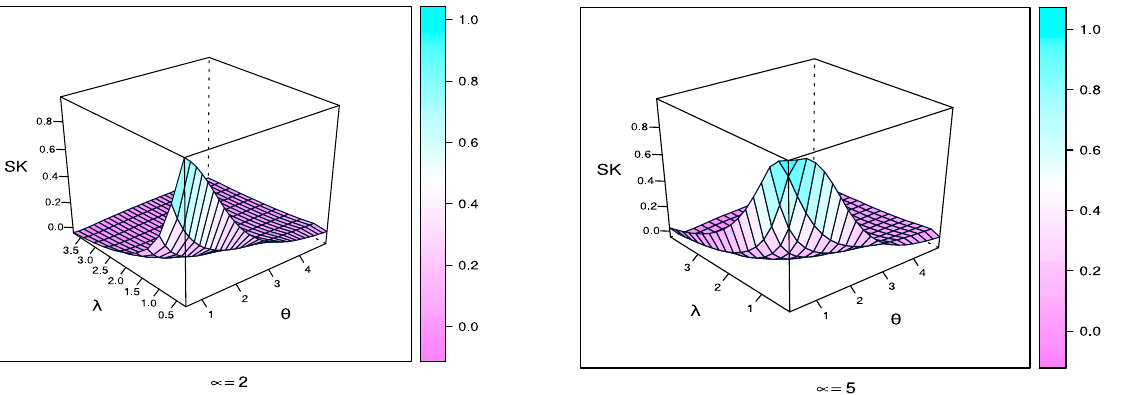
Figure 4. Skewness plot for TCPWE distribution with different values of parameters when 𝜌 = 2 and 𝜌 = 5 .